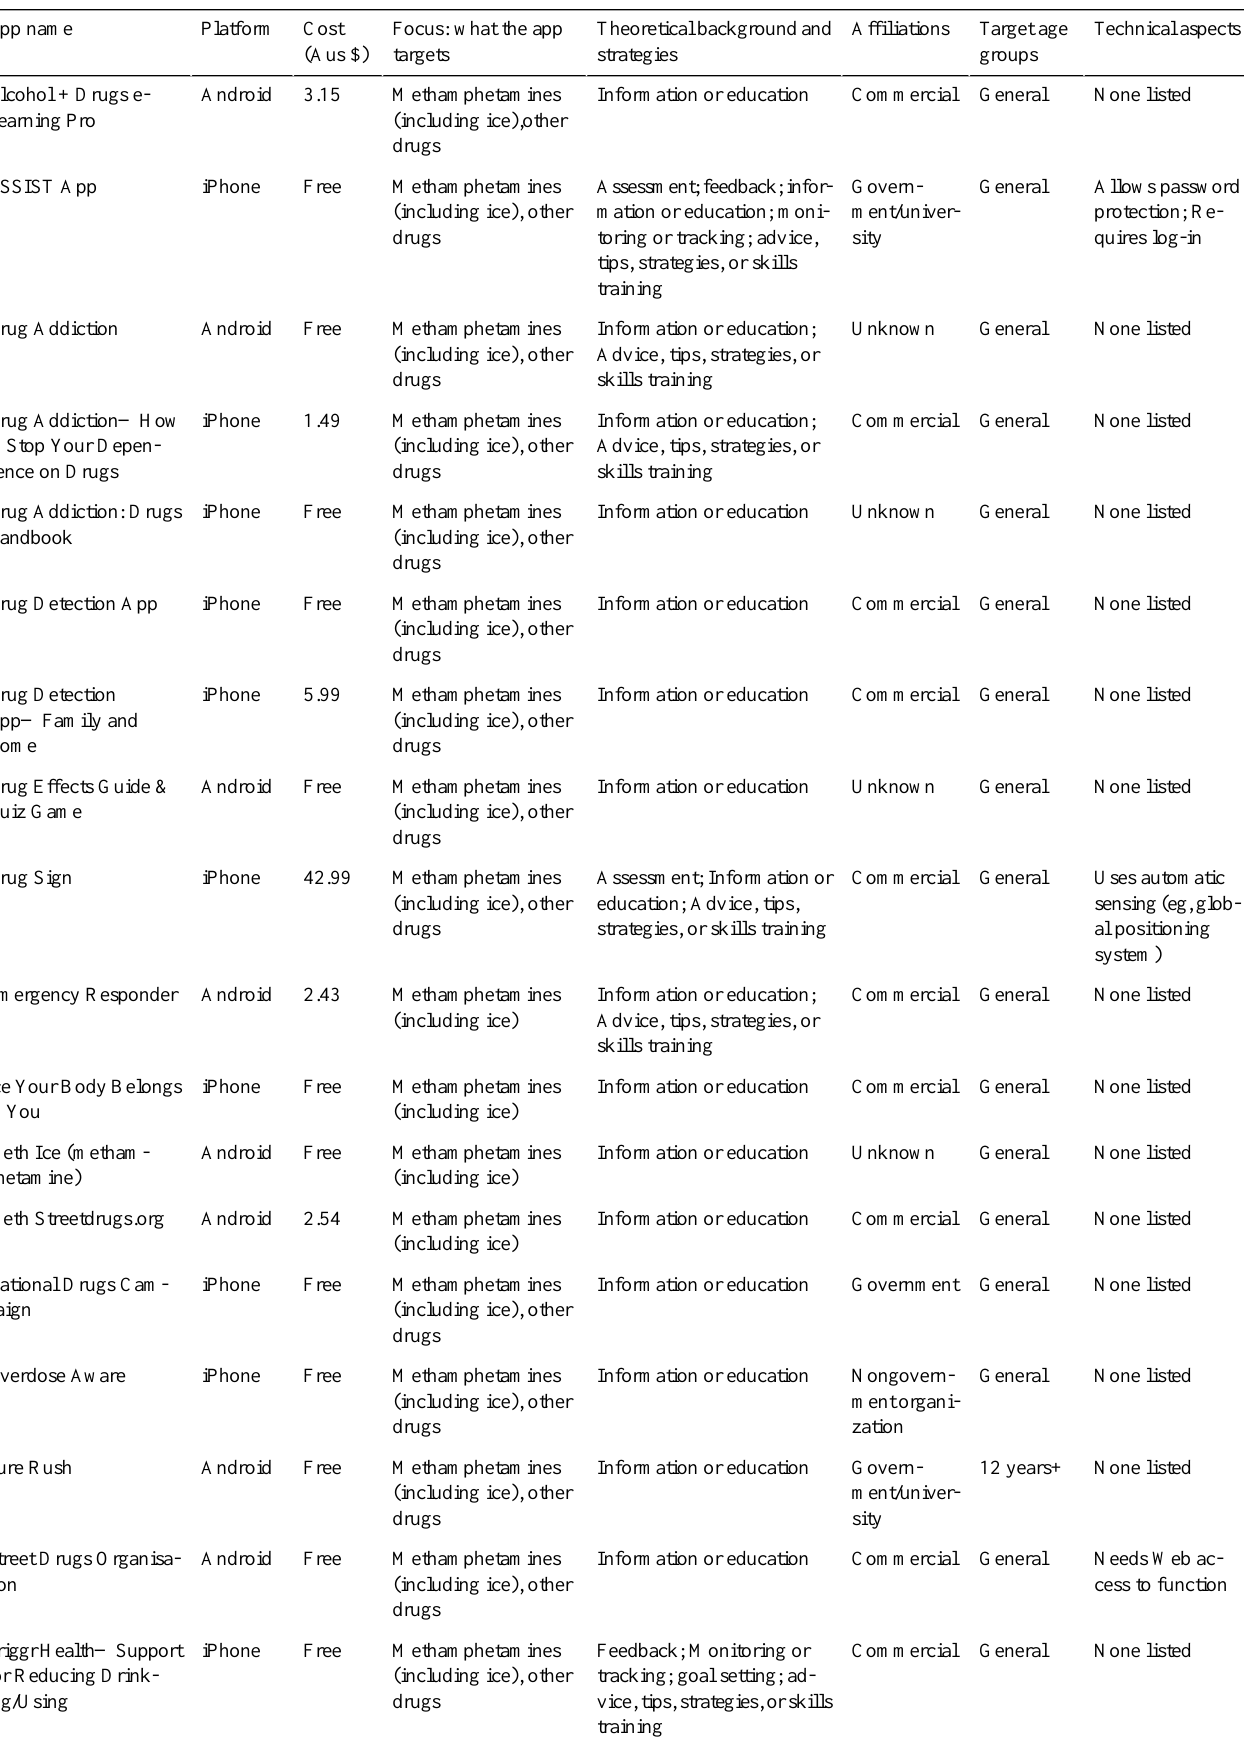
Table 1. The classification and content of included